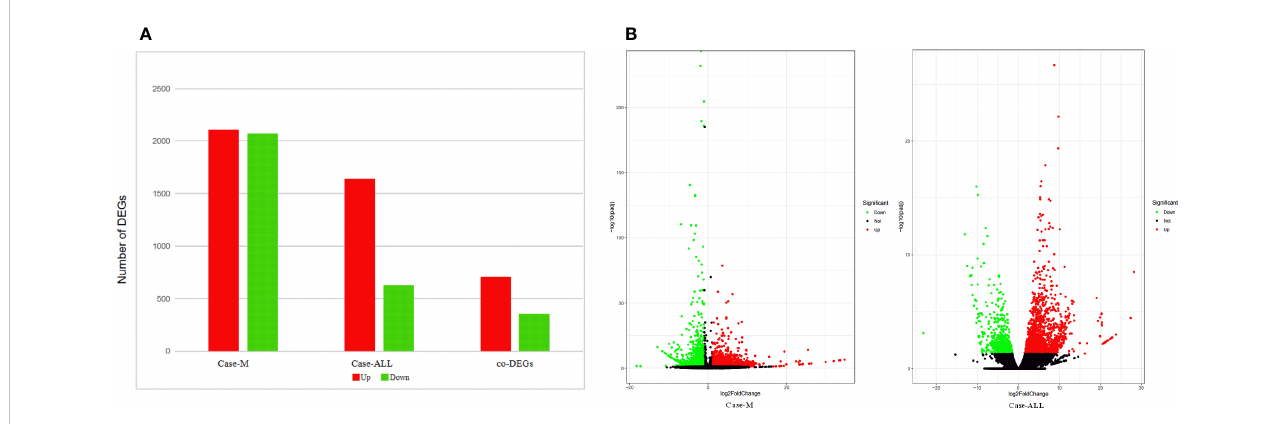
FIGURE 4 (A) DEGs between case group and M group, case group vs ALL group, co-DEGs between case vs ALL and case vs M; (B) Volcano map of DEGs. The x- axis is the log2 scale of the fold change of gene expression in case, ALL and M (log2(fold change)). Negative values indicate down regulation; positive values indicate up regulation. The y-axis is the minus log10 scale of the adjusted p values (elog10 (padj)), which indicates the signi fi cant level of expression difference. The red dots represent signi fi cantly up-regulated genes with at least two fold change, while the green dots represent signi fi cantly down-regulated genes with at least two fold change.